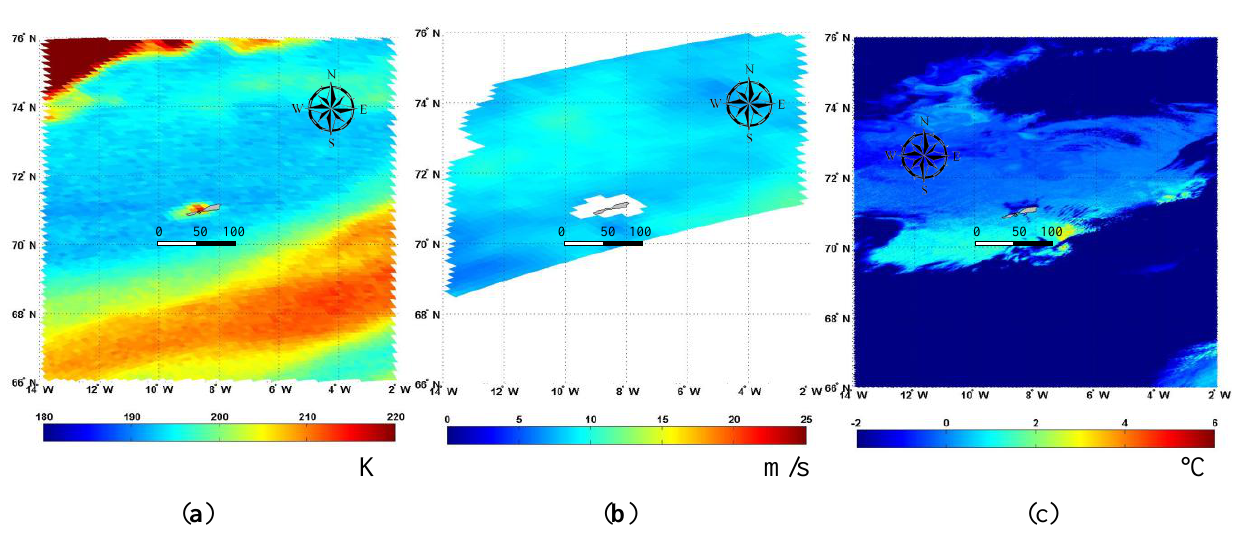
Figure 3. Satellite data fields taken over Jan Mayen radiosonde station on 3 May 2011: ( a ) Aqua AMSR-E brightness temperature at 23.8 GHz, vertical polarization, 12:28 UTC; ( b ) MetOp ASCAT wind speed, 13:34 UTC; ( c ) Aqua MODIS SST, 12:30